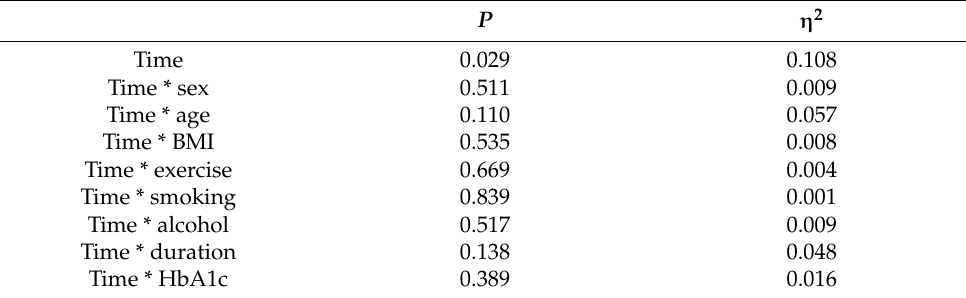
Table 4. Effect of COVID-19 pandemic on change in skeletal muscle mass